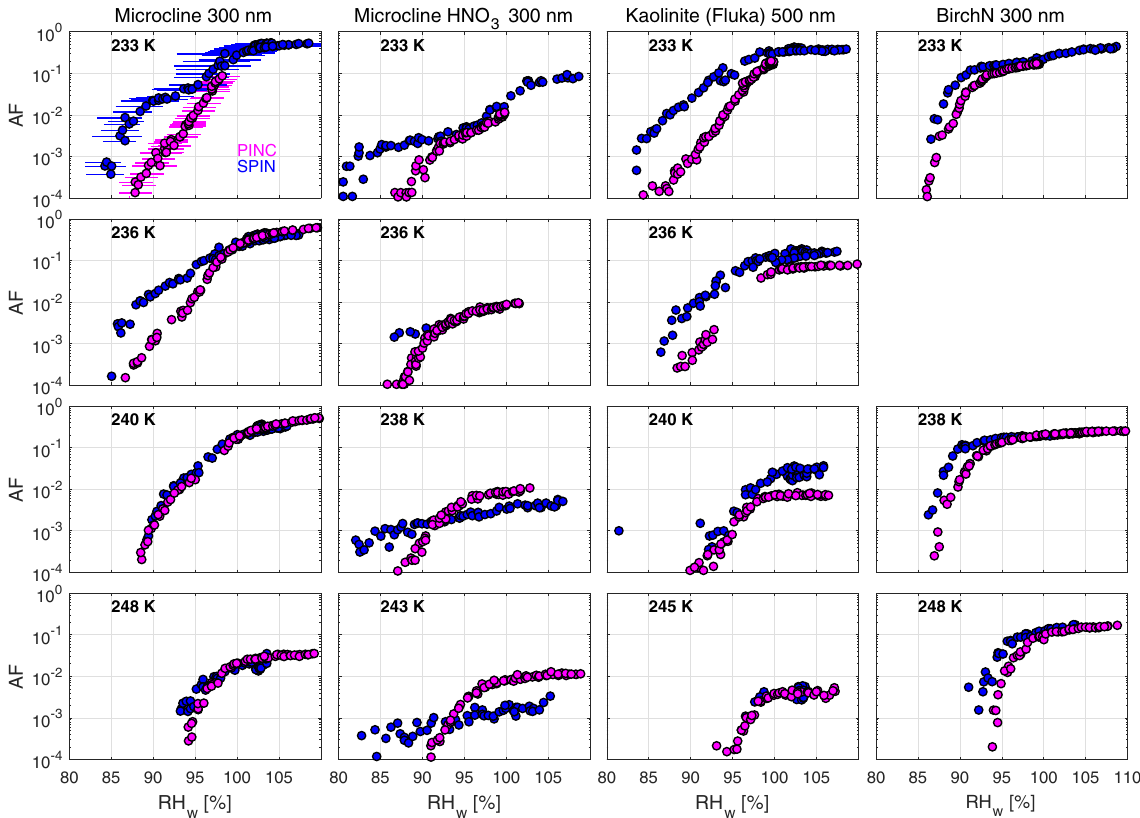
Figure 5. Resulting AF from RH w scans measured with PINC (magenta) and SPIN (blue) for four aerosol types. The upper left panel includes an example of measurement uncertainties in the AF (not visible) and RH w